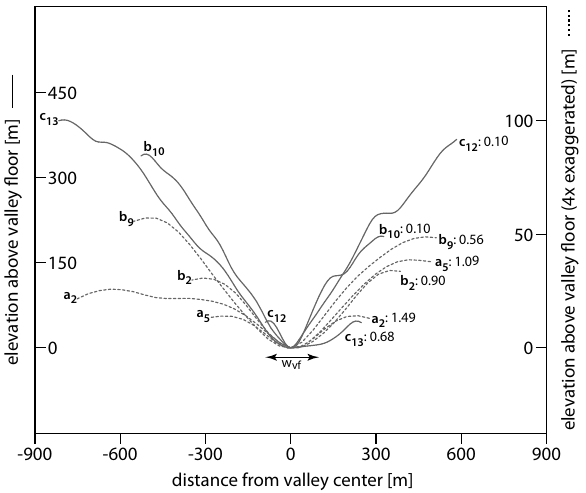
, a , b , b , b , 2 5 2 9 10